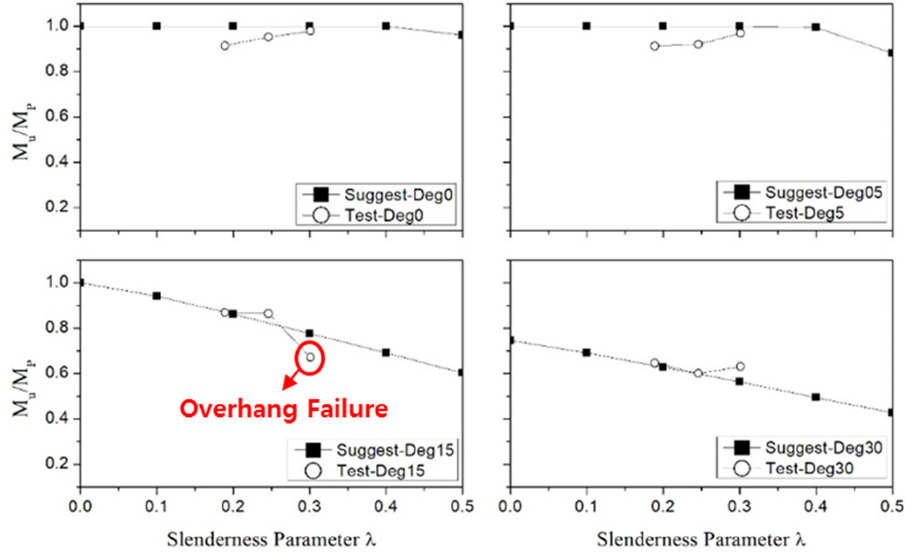
Figure 18. Ultimate Strength Comparison per Slenderness Parameter.